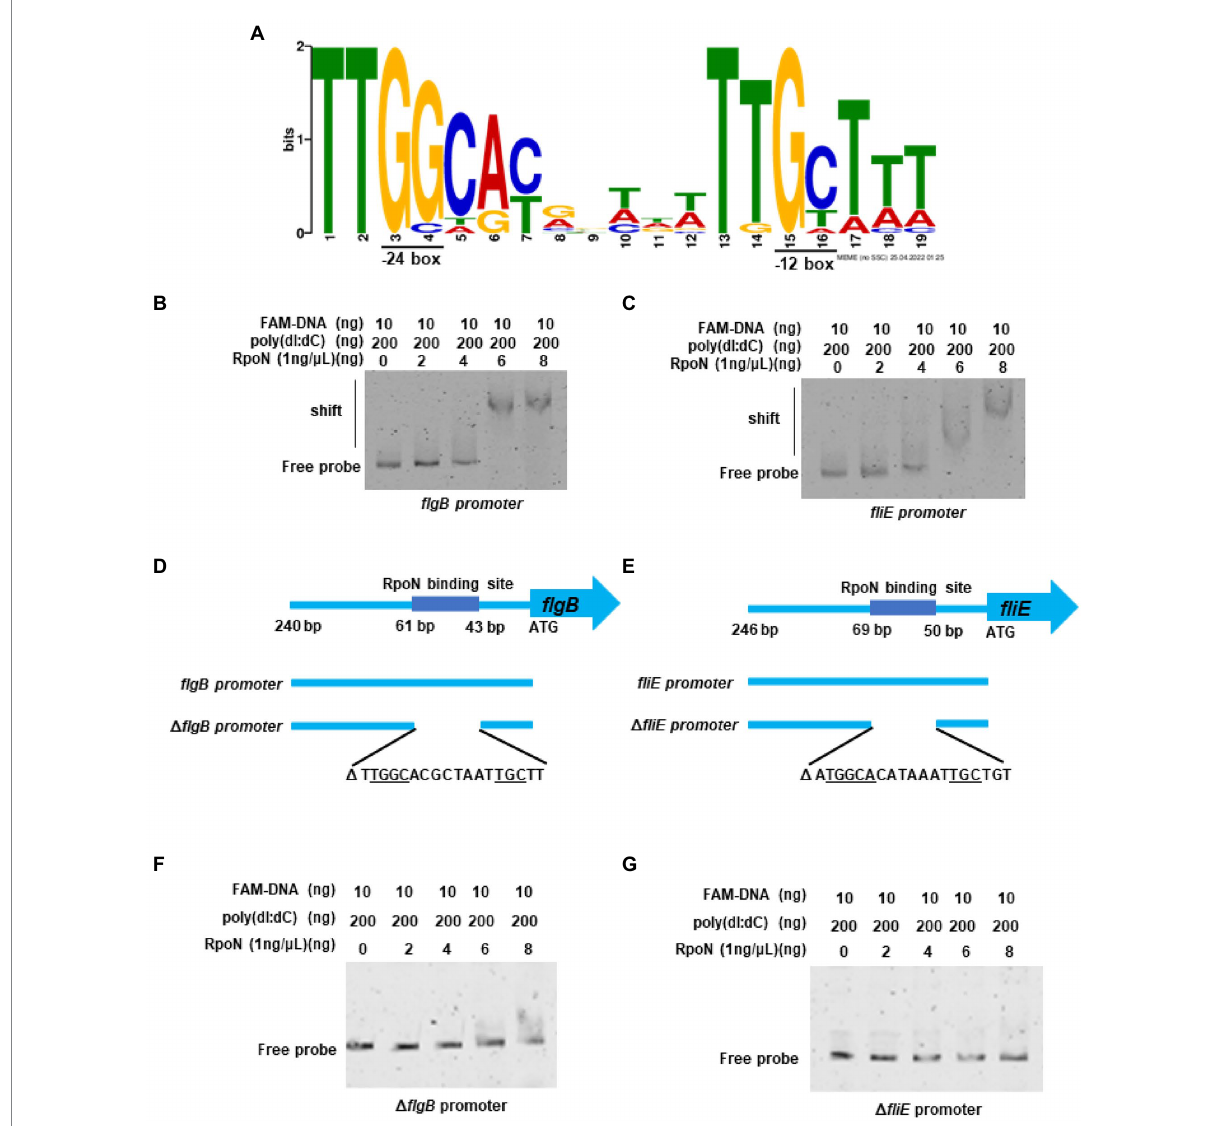
FIGURE 3 The RpoN directly binds to the promoters of flgB and fliE . (A) The binding motif of RpoN was generated by MEME-Suit tool based on the 21 promoter regions of the gene differentially expressed in our RNA-seq and overlapped with the ChIP-seq of V. cholerae . The height of each base indicates the frequency of occurrence at each location. (B,C) EMSA revealed that RpoN directly binds to the promoter regions of flgB (b) and fliE (C) . (D) The promoter region of the flgB . The RpoN binding sites and the probes of flgB promoter (240 bp) and the ∆ flgB promoter with deletion of RpoN binding site ranging from bp 43–61 relative to start site ATG. (E) The promoter region of the fliE . The RpoN binding sites and the probes of fliE promoter (246 bp) and the ∆ fliE promoter with deletion of RpoN binding site ranging from bp 50–69 relative to start site ATG. (F,G) EMSA was performed to assess the binding of RpoN to specific RpoN binding site-deleted promoters ∆ flgB (F) and ∆ fliE (G)